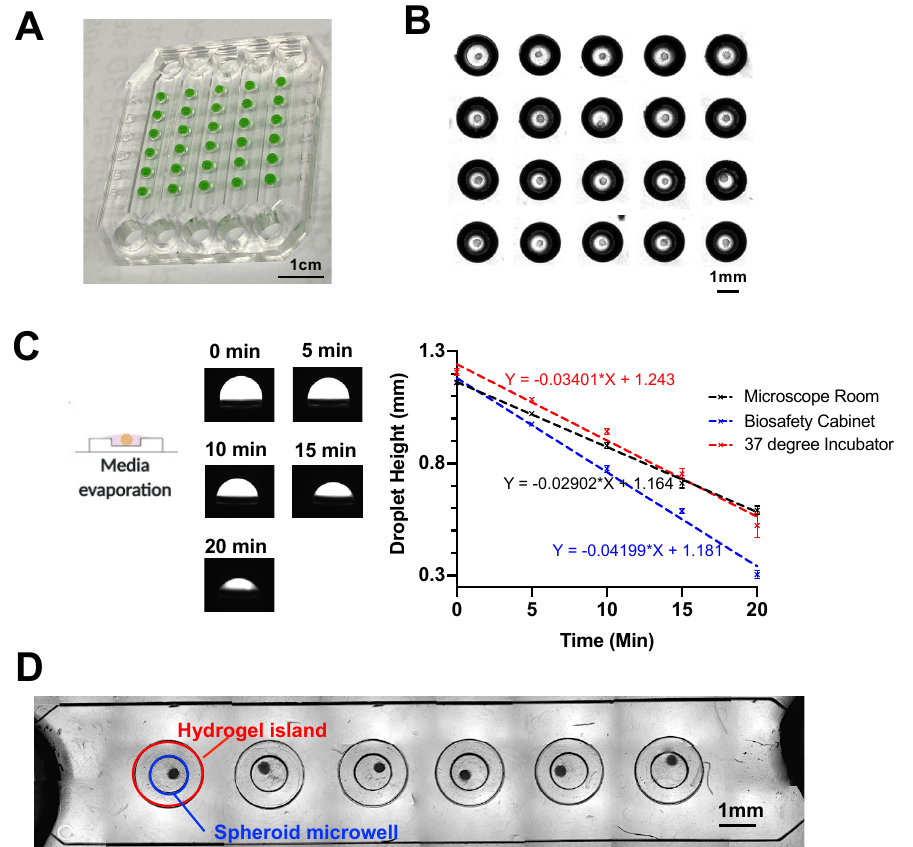
Figure 4. In-place encapsulation of spheroid on the microarray chip. ( A ) Image of water droplet (mixed with food dye) confined within a 5 × 6 microarray chip. ( B ) Stitched brightfield image of spheroids in hanging drop after culturing on chip for 2 days. ( C ) Evaporation rate of media droplet in three different environments. Data are presented as the mean ± SD. ( n = 3) ( D ) Stitched brightfield image of a single channel of the 5 × 6 microarray chip with spheroids embedded within collagen gel. Red circle indicates the region of hydrogel island, and blue circle indicates the region of the spheroid